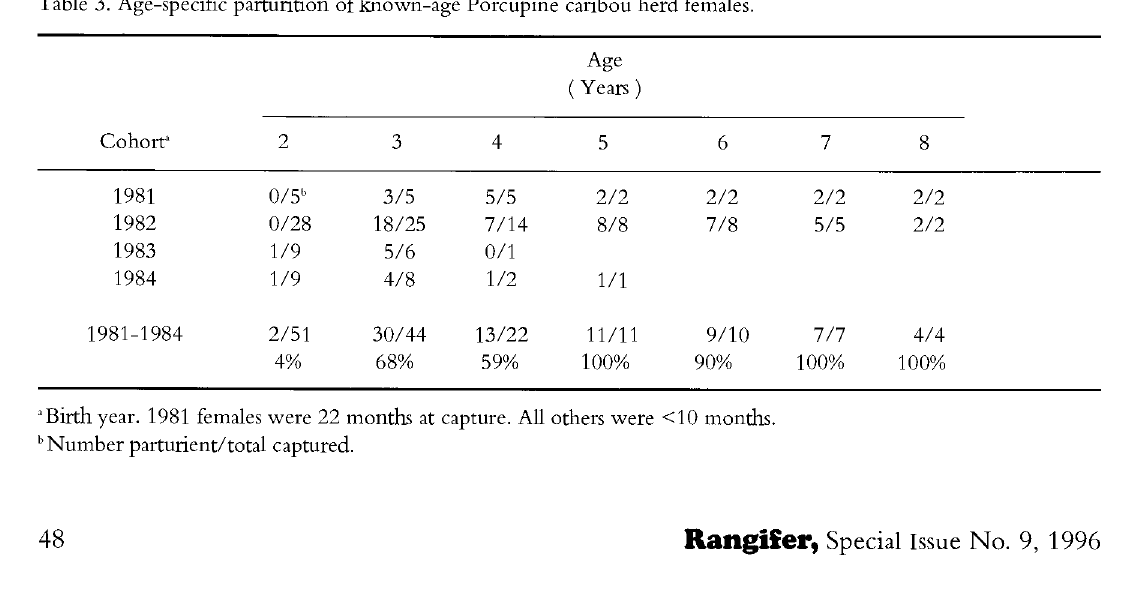
Table 3. Age-specific parturition of known-age Porcupine caribou herd